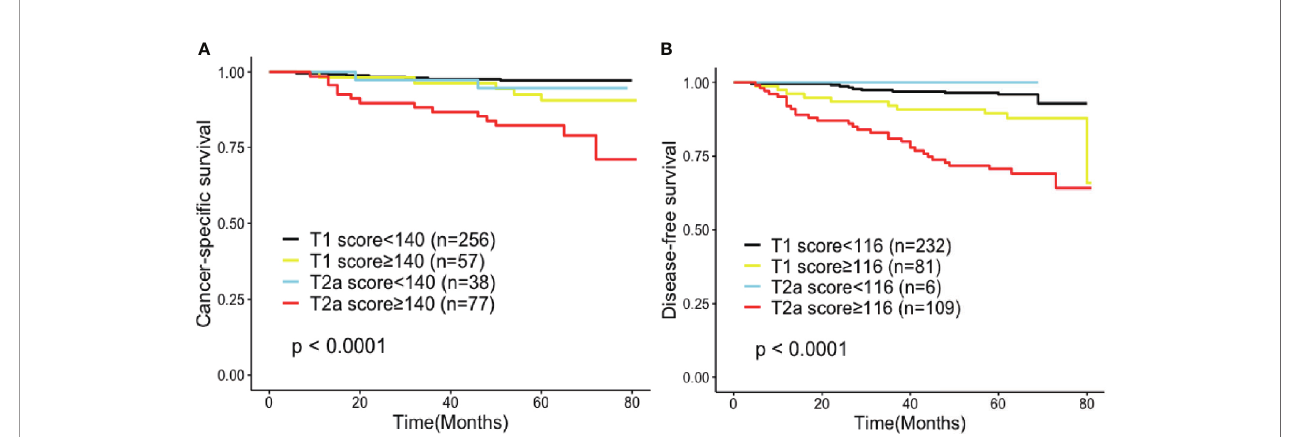
FIGURE 7 | Risk group strati fi cation within each staging system (IA, IB) in (A) cancer-speci fi c survival and (B) disease-free survival.